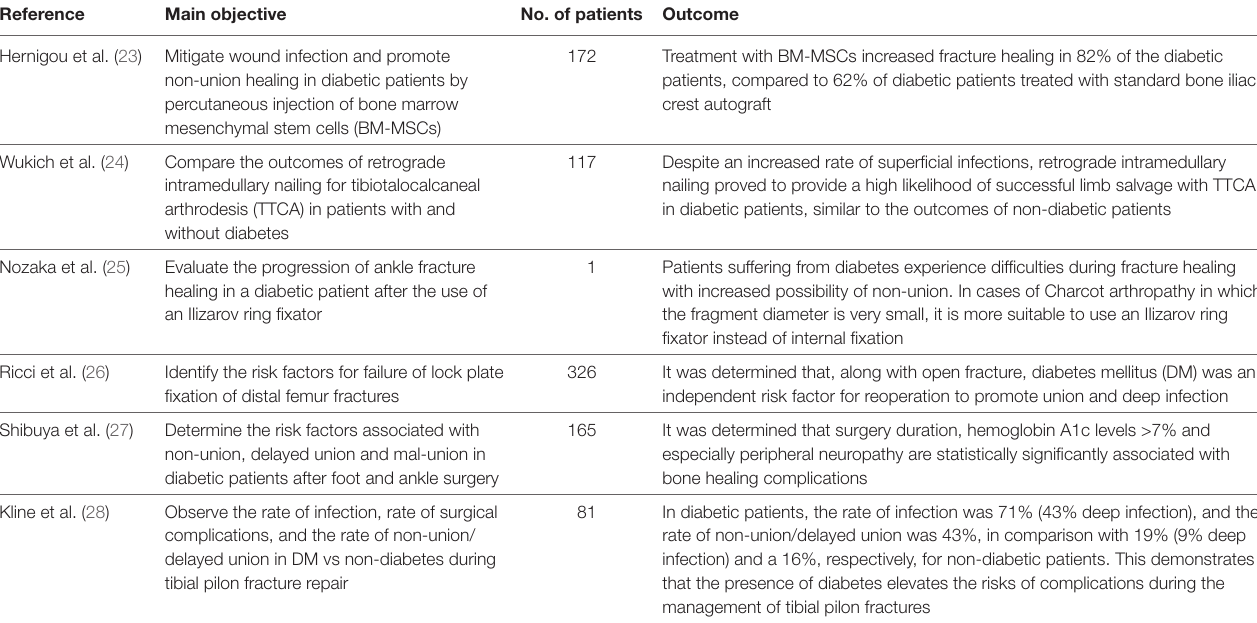
TaBle 3 | Clinical studies on bone healing in type 2 diabetes mellitus published between January 2007 and March 2017 (in descending order). Reference Main